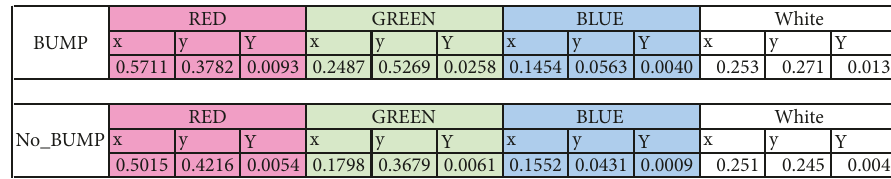
Figure 4: Simulated result of chromaticity and photometry ( Y ) in bump and no-bump region.